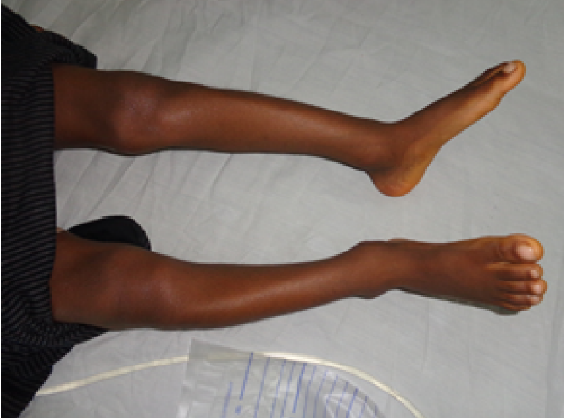
Figure 2. Widening of the ankles and deformities of the lower limbs.